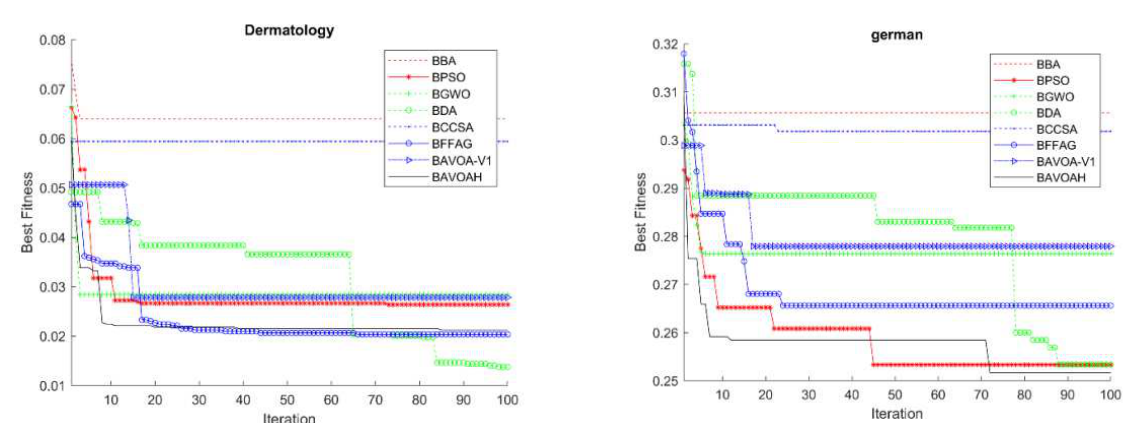
Figure 15. Comparison of the degree of convergence of the proposed BAOVAH (hyper-heuristic) and BAVOA-V1 (multi-strategy) method on the first six data sets.